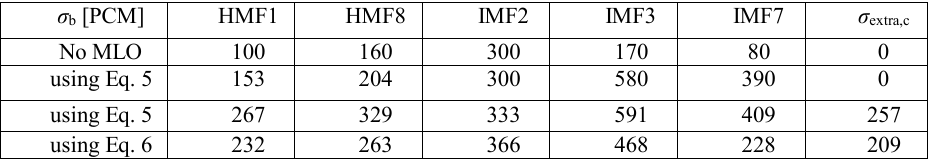
Table 1. Table of resulting σ b . The second row contains σ reported (No MLO performed). In the